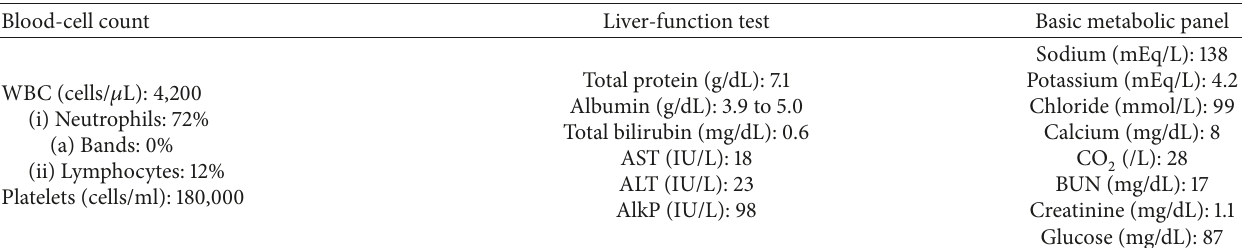
Table 3: Selected patient CBC and CMP results.